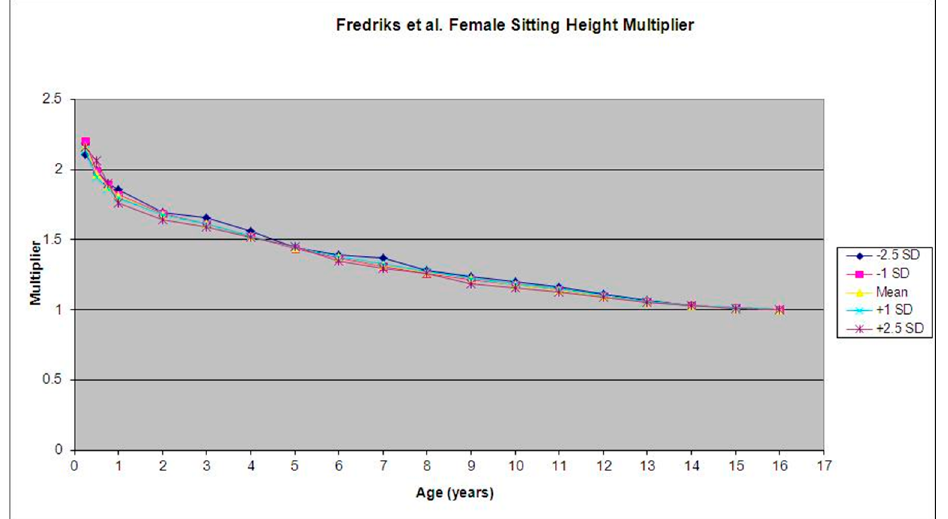
Figure 1. Mean and standard deviation for the female sitting height multiplier were calculated using data from Fredriks et al. [9].